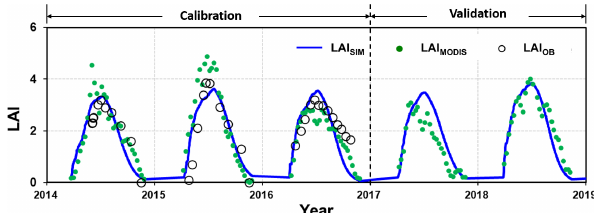
Figure 5. Comparison of the leaf area index (LAI) from simu- lation (LAI SIM ), MODIS-derived data (LAI MODIS ), and plot ob- servation (LAI OB ) for the calibration (2014–2016) and valida- tion (2017–2018) periods.